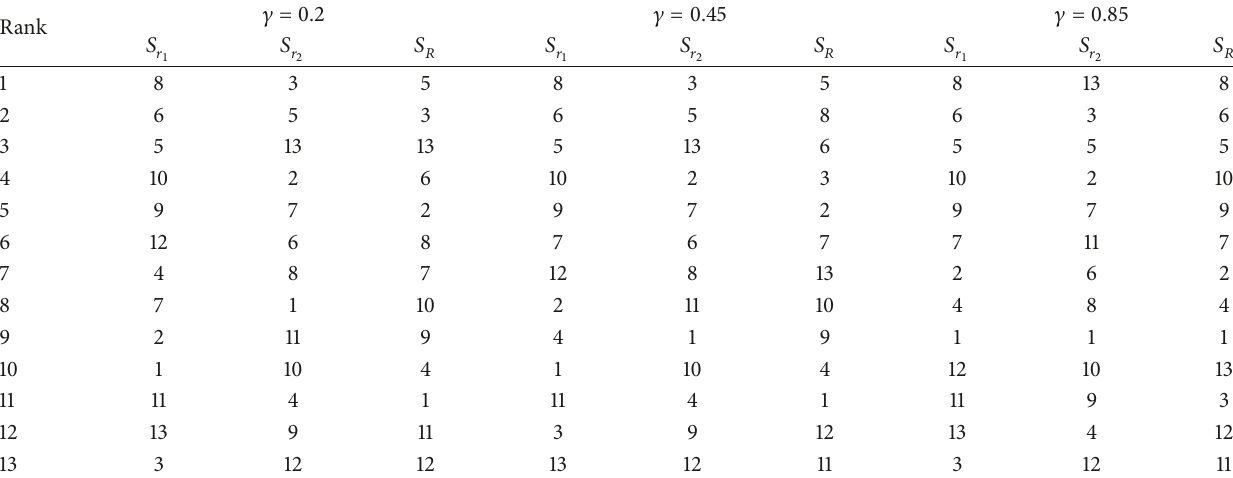
Table 2: The ranks of the importance of